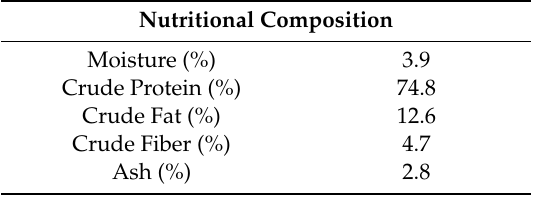
Table 1. Yellow mealworm meal (ŸnMeal TM ) proximate composition (% Dry